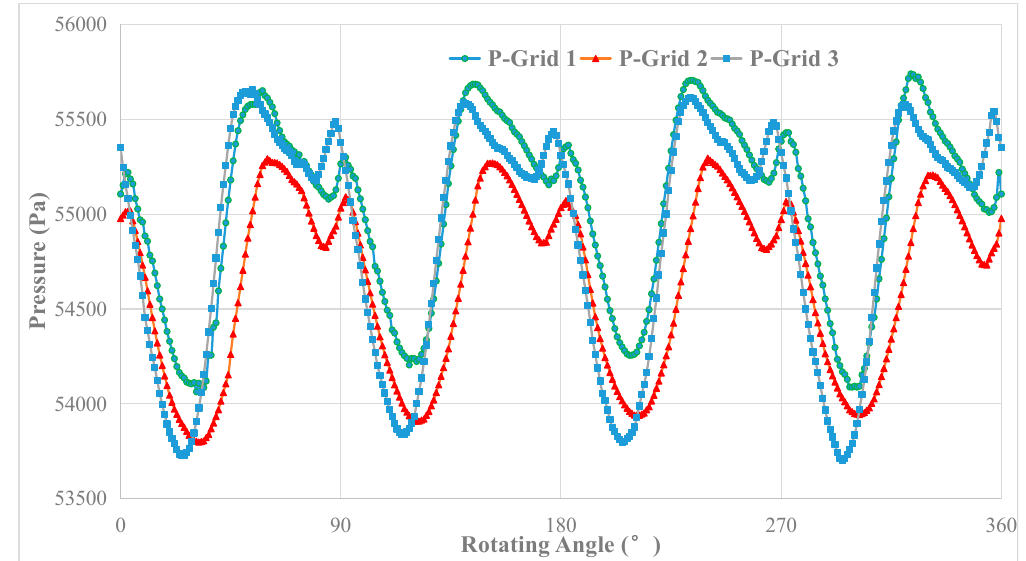
Figure 10. The variation of pressure at P10 over the last full propeller revolution.